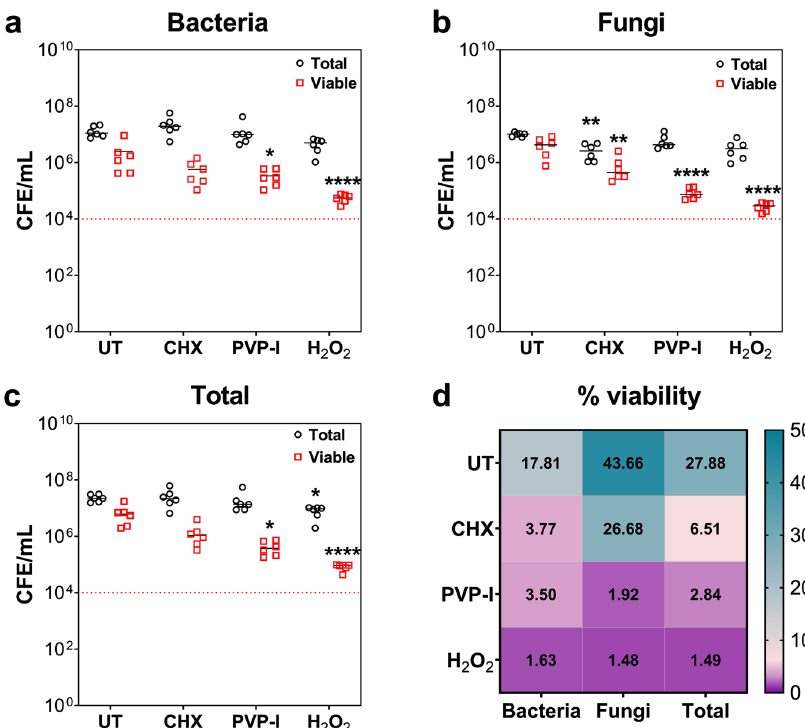
Fig. 3 Testing the ef fi cacy of the three anti-bio fi lm wound washes. 24-hour bio fi lms were treated with 3% H 2 O 2 , 10% w/v PVP-I, and 0.05% CHX for 24 hours at 37 o C under anaerobic conditions. Following treatment, viability of the bio fi lms were assessed using live/dead qPCR analyses for total bacterial counts (16 S; a ), total fungal counts (18 S; b ) and combined counts ( c ). % viability was calculated using the above counts for total vs. viable cells ( d ). Statistical signi fi cance was determined using a two-tailed Student ’ s t-test to compare the means of treated bio fi lms vs untreated bio fi lms (* p < 0.05, ** p < 0.01, **** p <